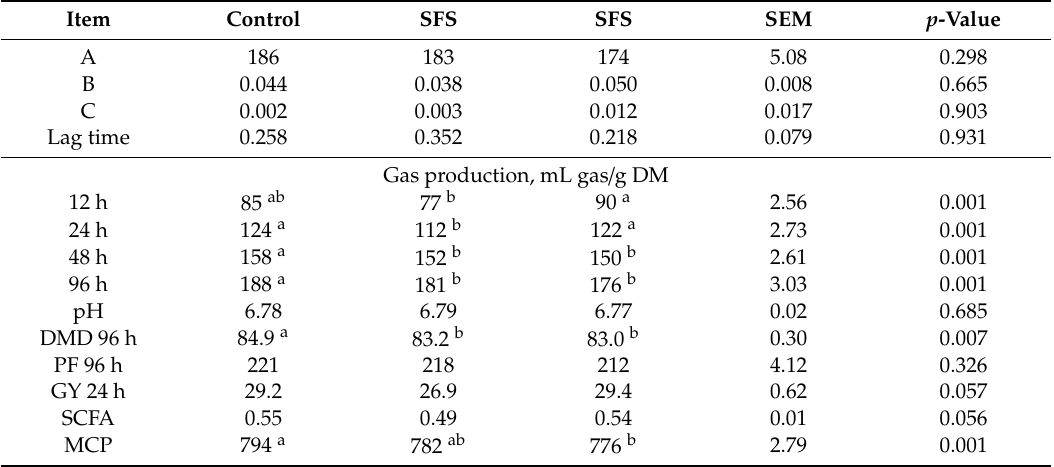
Table 6. In vitro rumen gas kinetics (mL gas / g DM) and fermentation profile of di ff erent diets in dairy sheep fed control, sunflower seeds (SF) and sunflower seeds silage (SFS)